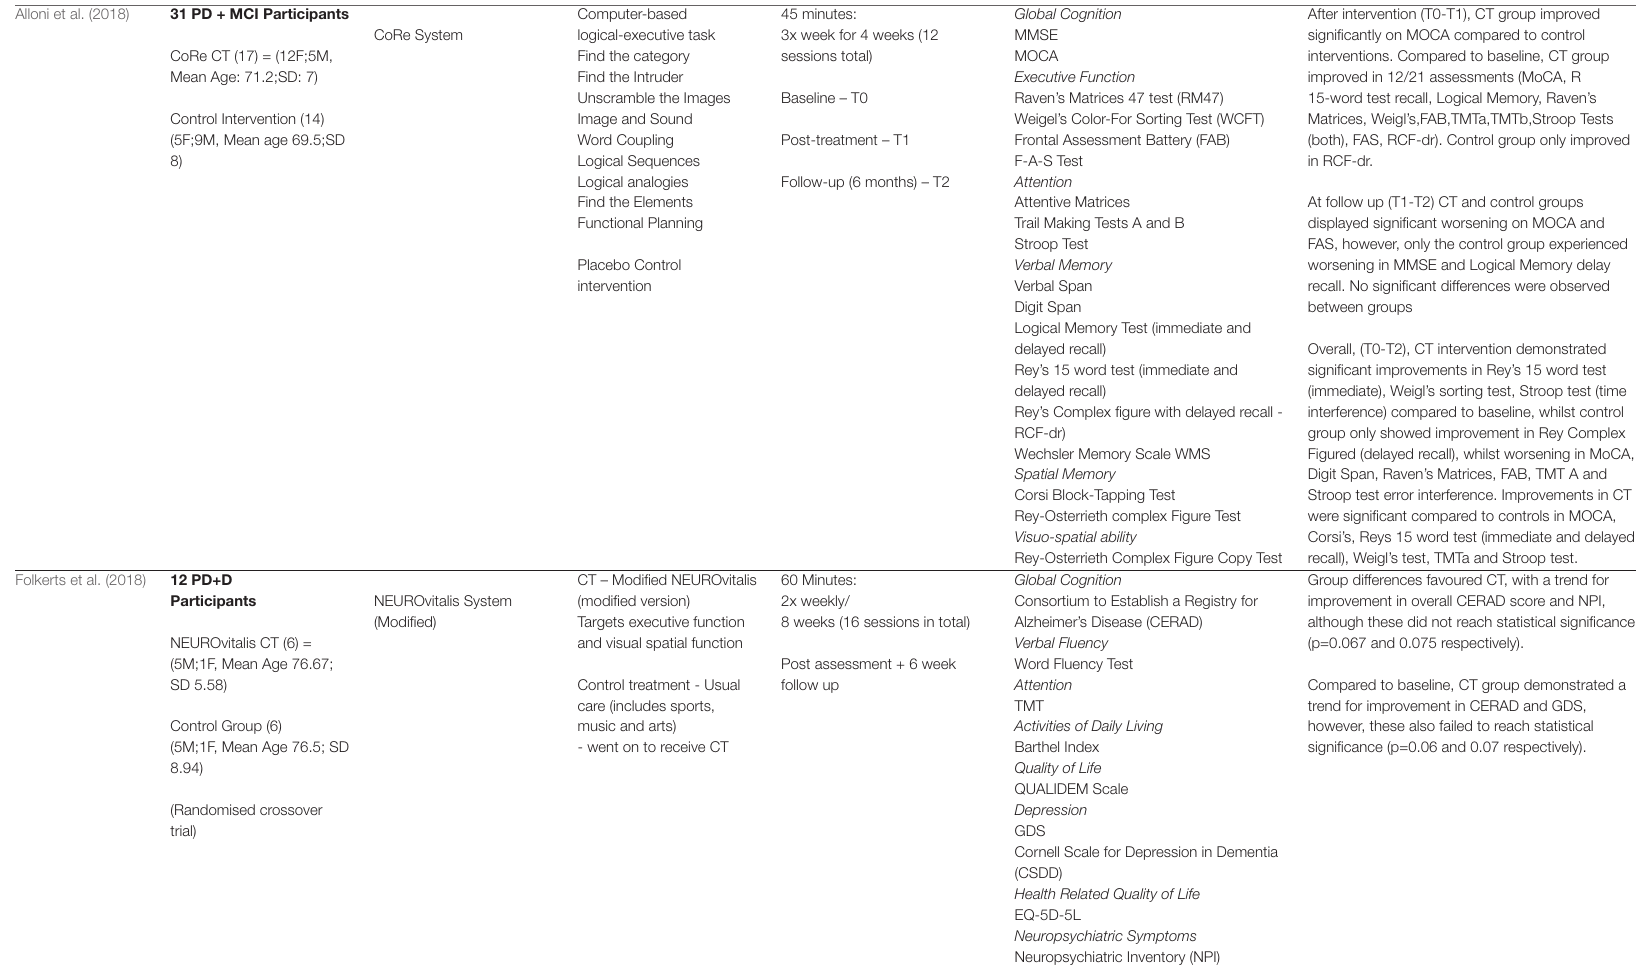
After intervention (T0-T1), CT group improved significantly on MOCA compared to control interventions. Compared to baseline, CT group improved in 12/21 assessments (MoCA,